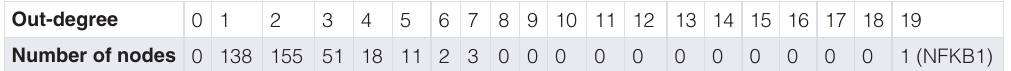
Table 3. Node distribution by out degree score. Cytoscape’s NetworkAnalyzer tool was used to present out-degree score. NFKB1 has an outstanding out-degree score.